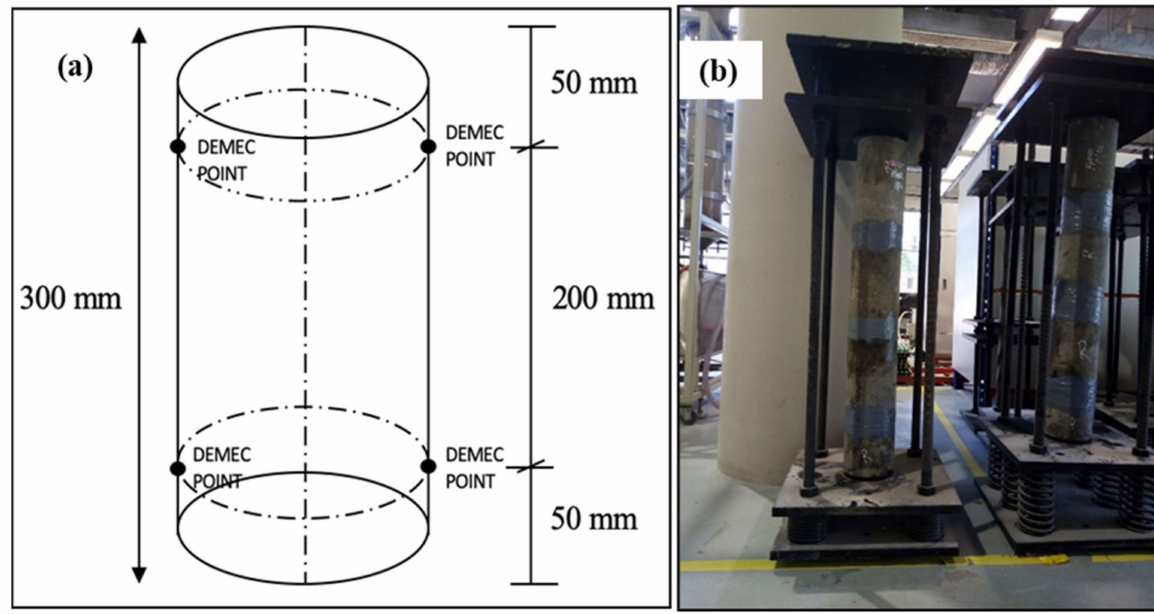
Figure 3. ( a ) Demountable mechanical strain gauge point positions on creep specimen and ( b ) creep loading